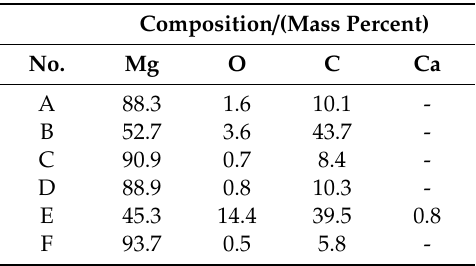
Table 4. EDS analysis results of Mg vapor condensation in di ff erent condensation zones (1473 K heating and 0.2 m 3 / h